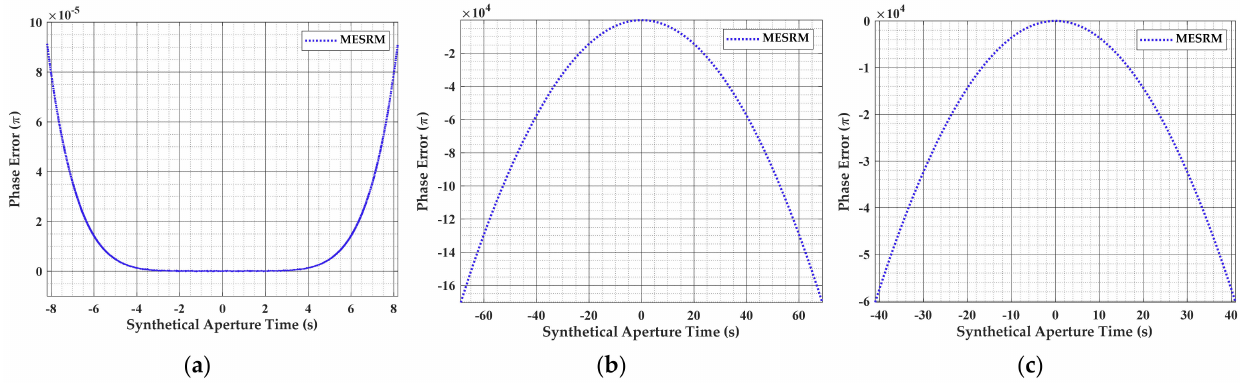
Figure 7. Phase error caused by MESRM at different positions in HEO SAR. ( a ) At perigee. ( b ) At squint subduction section. ( c ) At